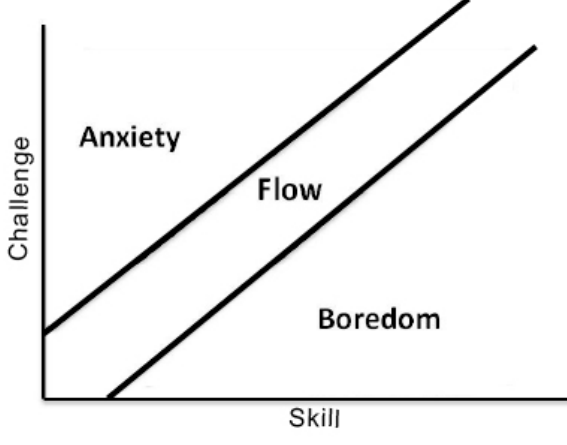
Figure 1. Flow state diagram.